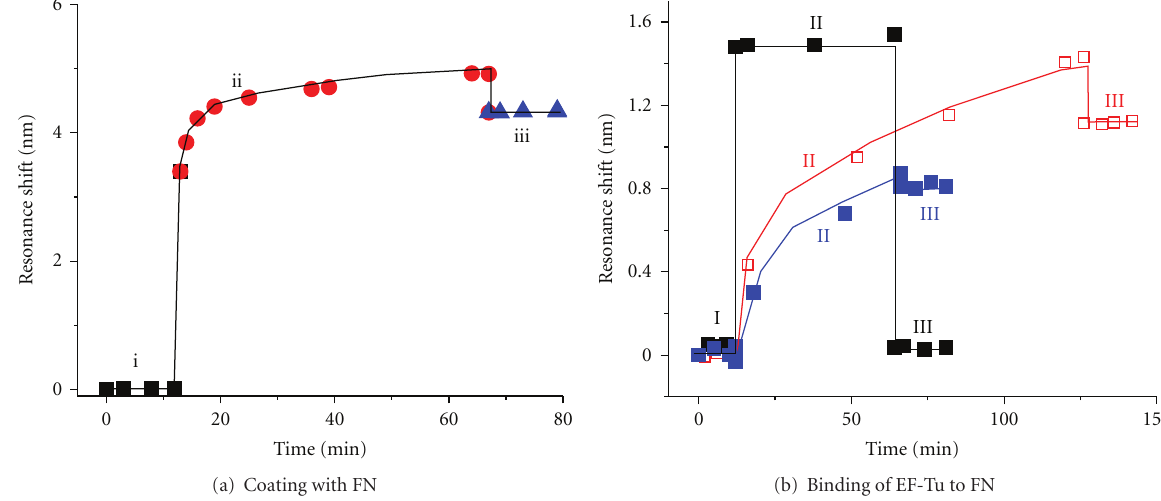
Figure 5: Interaction of EF-Tu and fibronectin characterized by a PC-TIR sensor. Binding of an analyte to a reactant causes resonant wavelength shift that was measured throughout the process as a function of time. (a) Coating the sensor with fibronectin. (i) The sensor surface was calibrated with PBS and (ii) coated with fibronectin (FN at 200 μ g/mL in a 200 μ L volume of PBS at 25 ◦ C). Immobilization of FN onto the sensor caused resonant wavelength shift. (iii) The subsequent washes. (b) Binding of EF-Tu to FN. (I) Detection baseline of the FN functionalized sensor. (II) EF-Tu at 20 μ g/mL (blue curve) or 50 μ g/mL (red) and a negative control (a portion of proteoglycan 4) at 20 μ g/mL (black) were incubated with FN at 25 ◦ C for the indicated times. (III) The sensor was